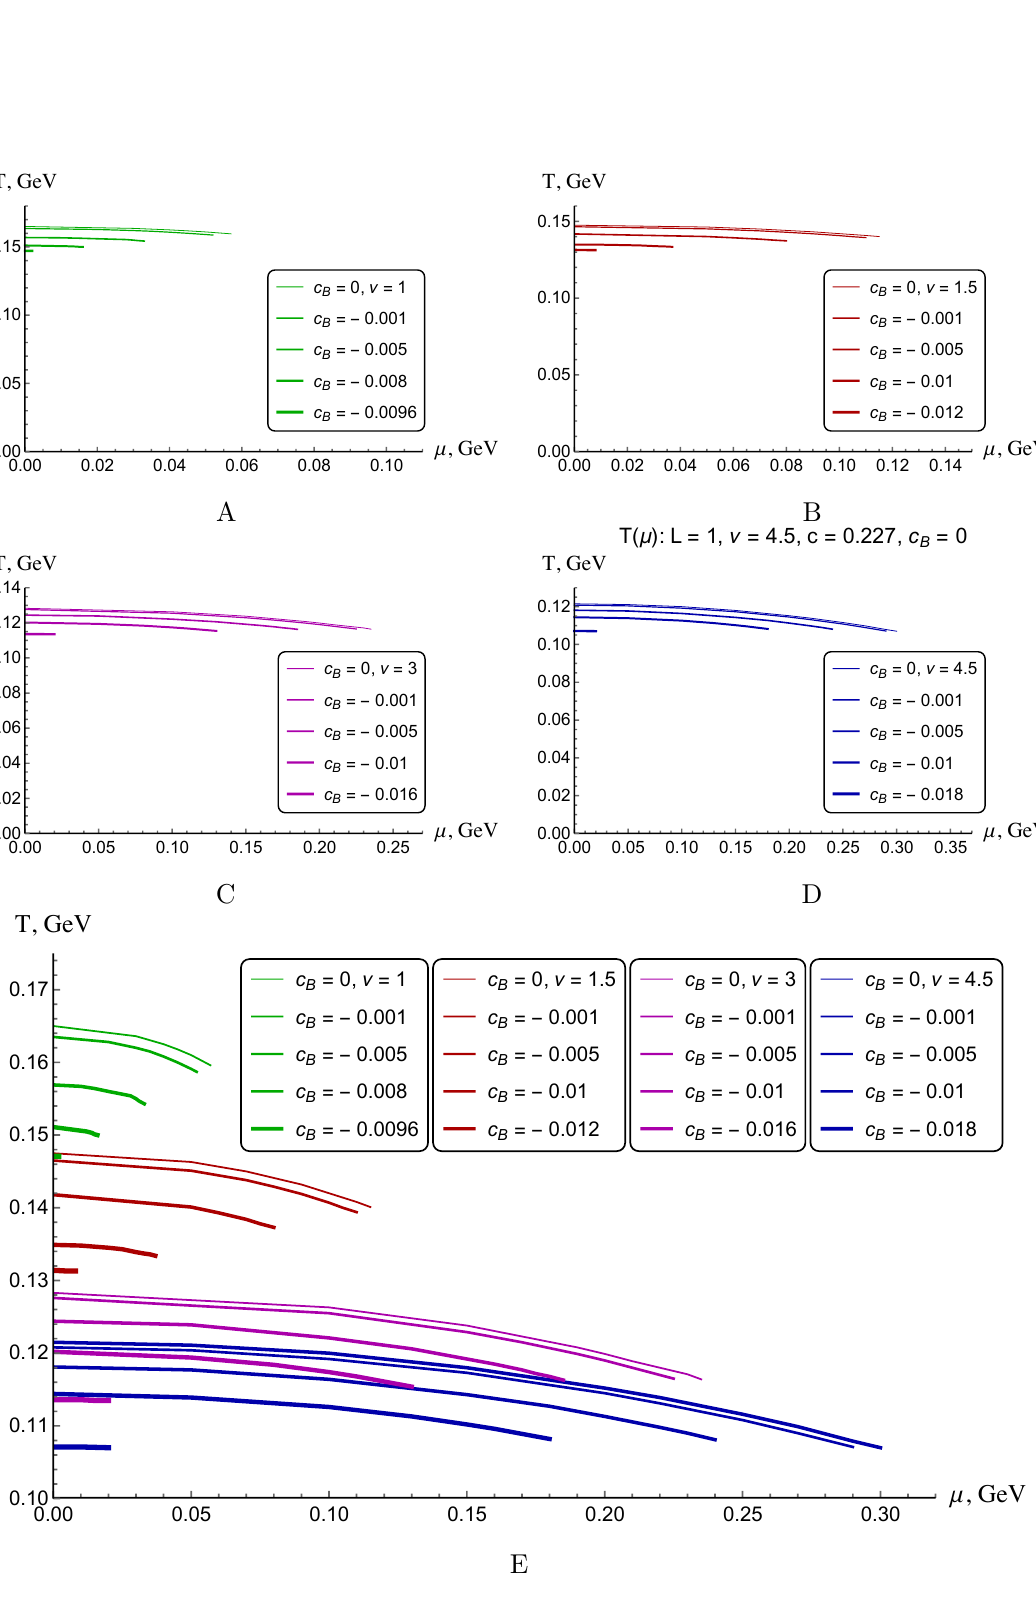
Figure 9 . Background phase transition lines depending on c B for ν = 1 (A), ν = 1 . 5 (B), ν = 3 (C), ν = 4 . 5 (D) and all of them together (E); c = 0 . 227